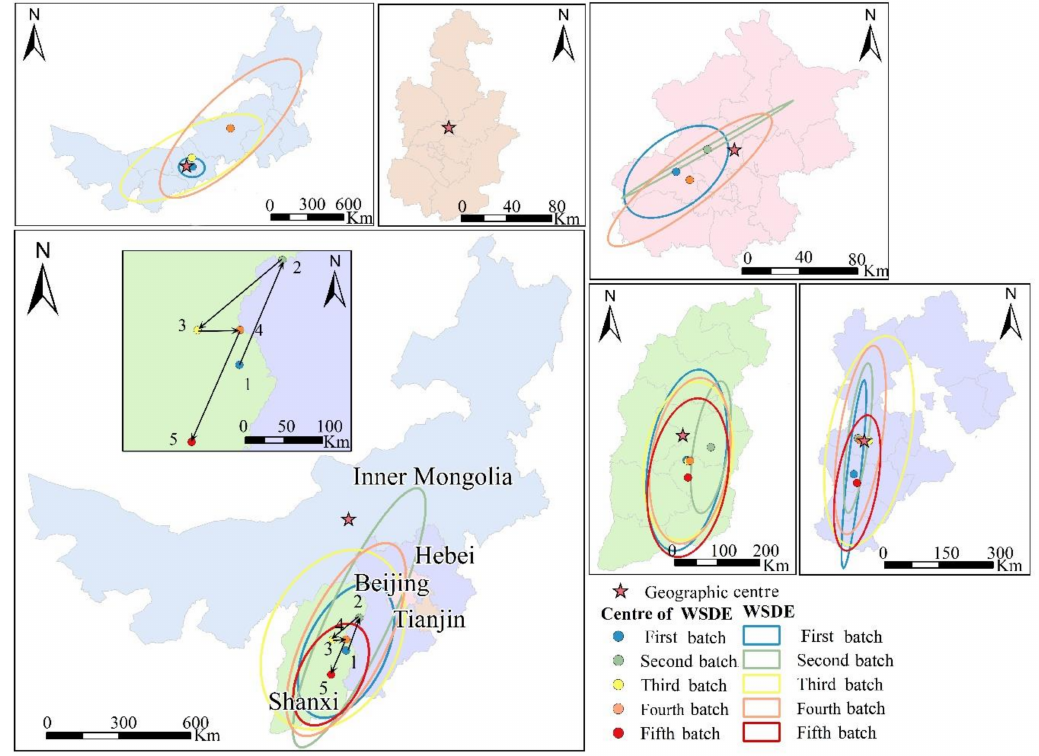
Figure 11. The WSDEs and center trajectories for northern China and subordinate